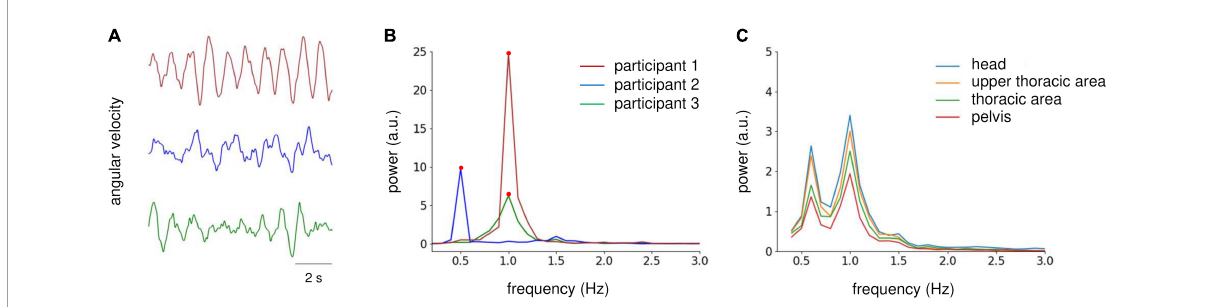
FIGURE2 Analysis of IMU sensor data on the yaw axis. (A) Raw angular velocity data at the yaw axis obtained from the head sensor of three participants during AC-GVS stimulation at the gait frequency in the imagery condition in Experiment 1. (B) Power spectrum density (PSD) of velocity data from the three participants shown in (A) (illustrated by the same color). We focused on the peak power (filled circles) from 0.3 to 5 Hz. (C) Grand average PSD across all participants for each IMU sensor in Experiment 1. The distribution of PSD was similar for all sensors. Therefore, we examined IMU data for the head